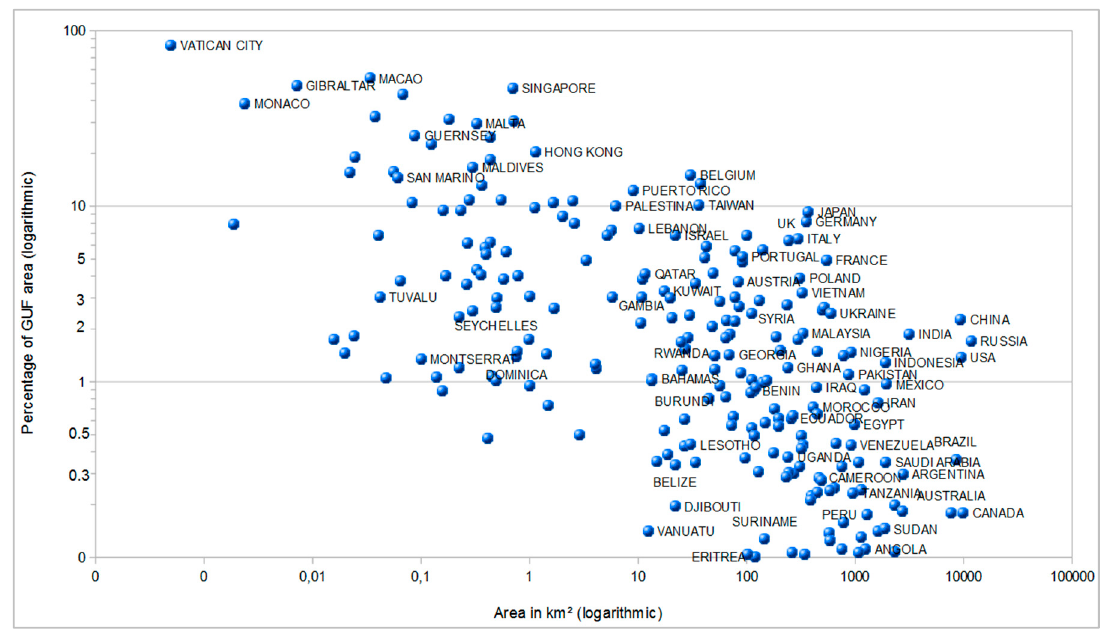
Figure 2. Scatterplot based on the GUF data showing the relation between the total administrative area and the percentage of settlement area for selected countries.